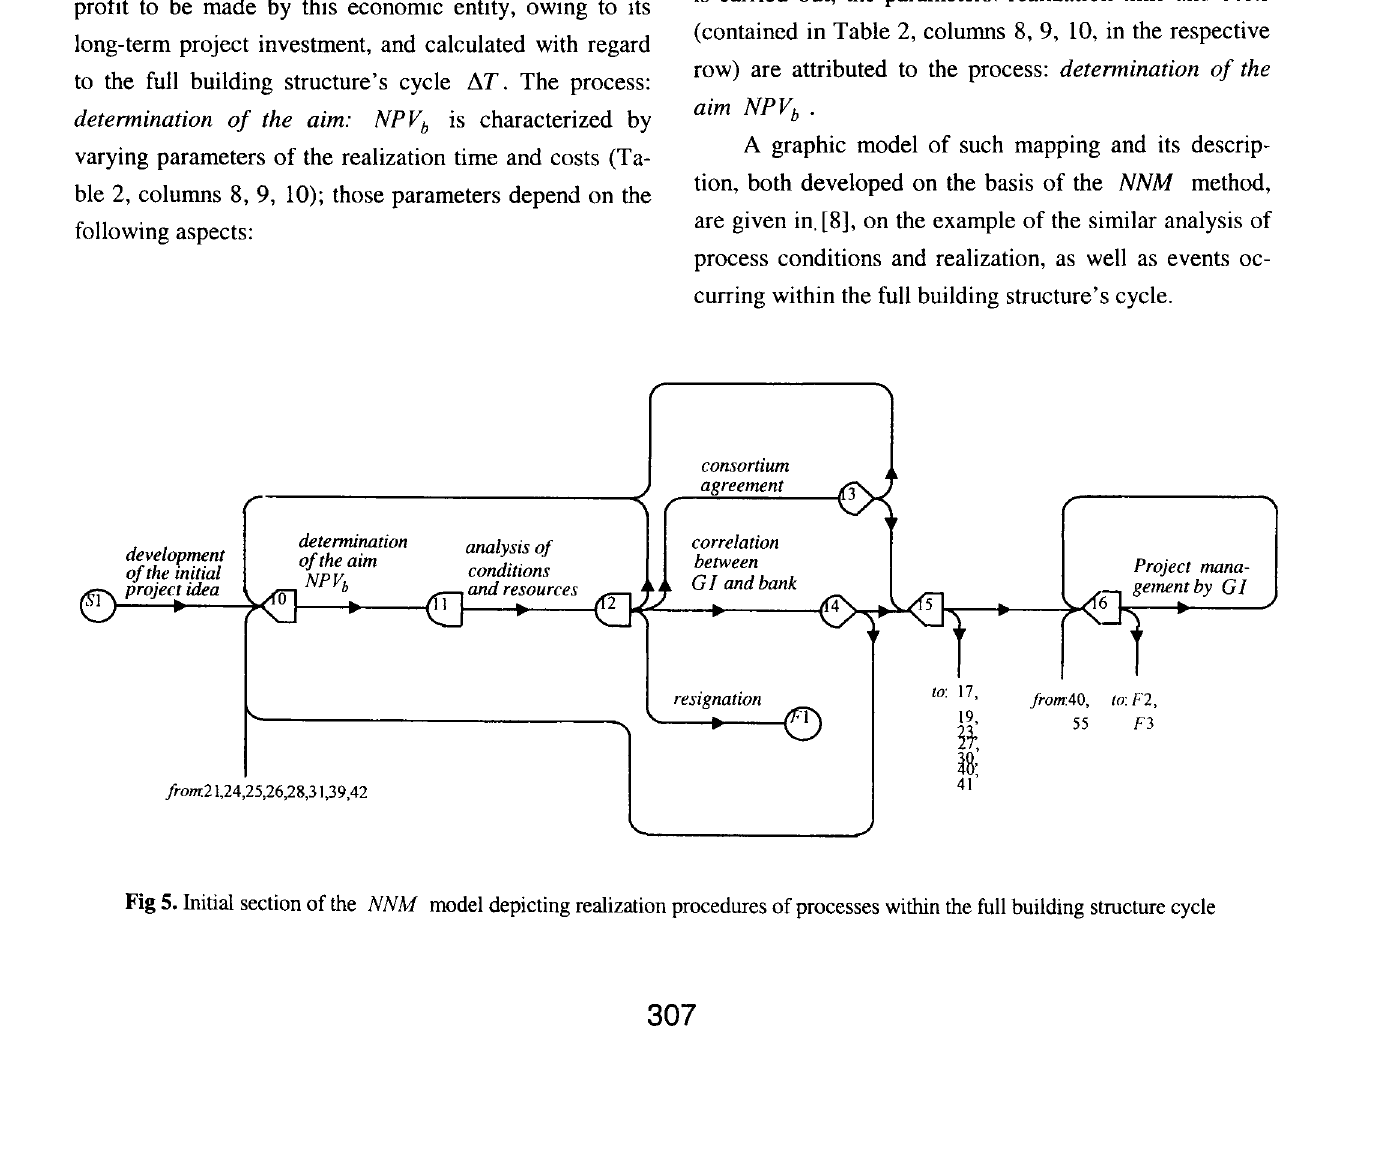
Fig 5. Initial section of the NNM model depicting realization procedures of processes within the full building structure cycle